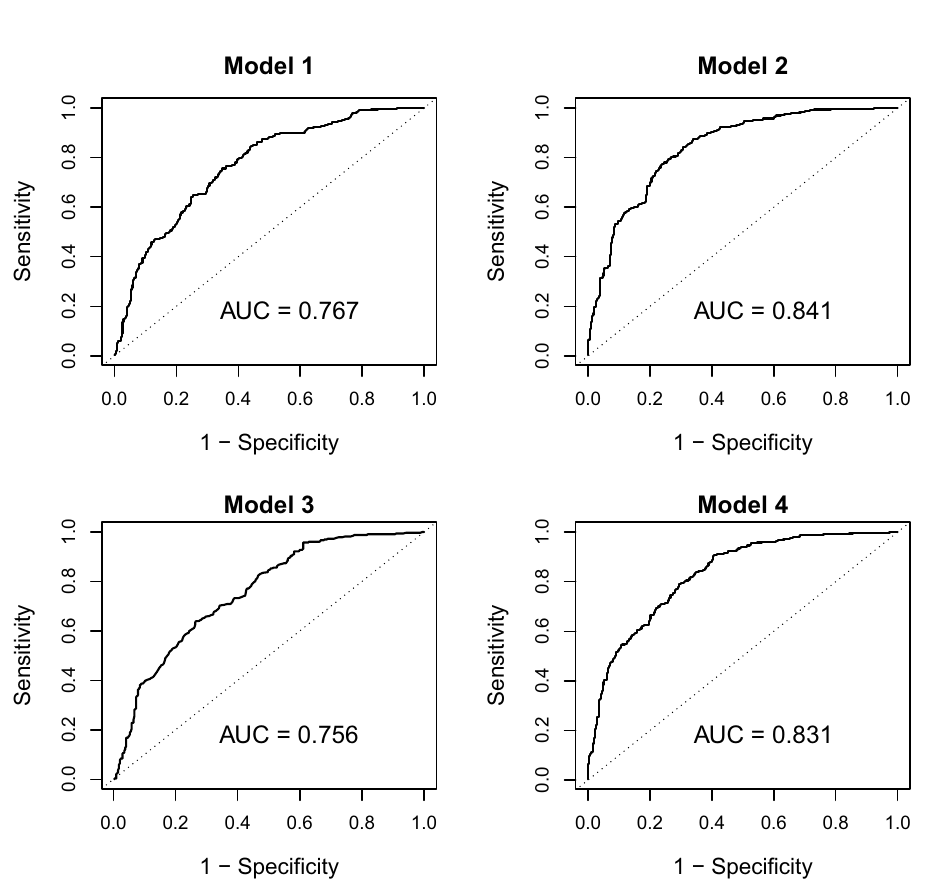
Figure 1. ROC curves for models 1–4 from the validation sample. Plots of the respective sensitivity against the false positive rate (1 minus specificity). The area under the curve (AUC) of an ideal binary classifier is 1, the AUC of a test without discriminatory power is